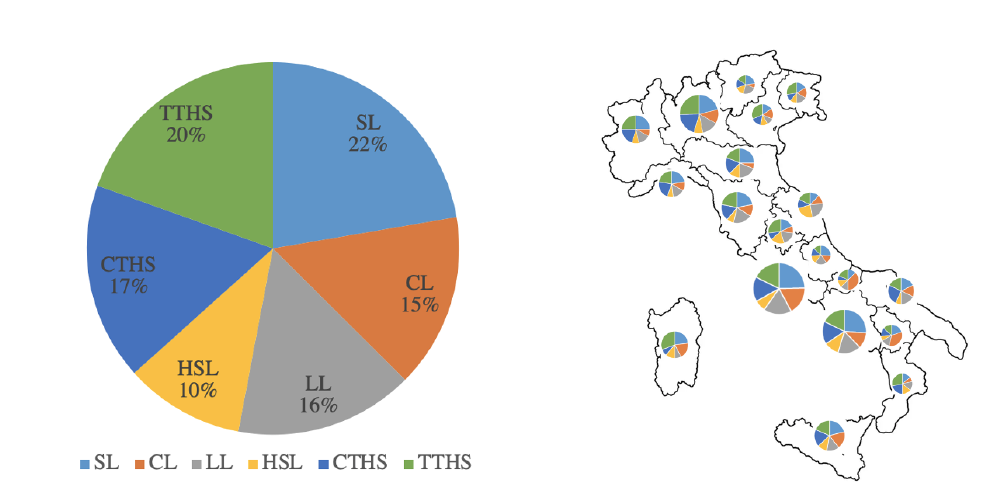
Figure 1: Typologies of high schools in